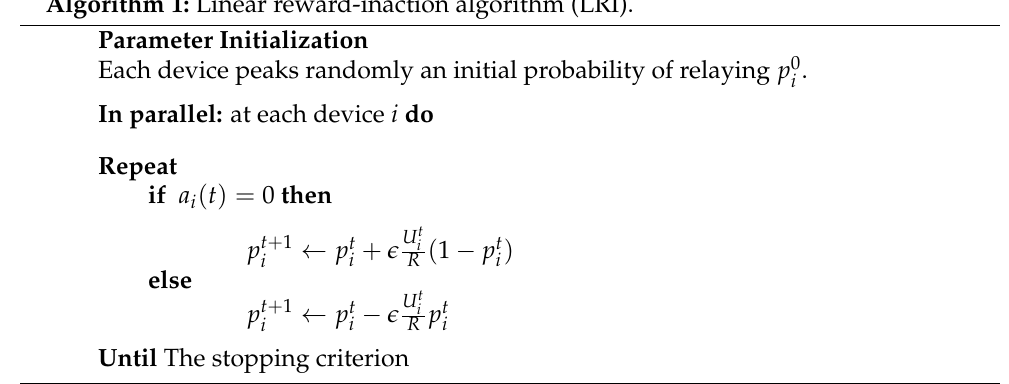
Algorithm 1: Linear reward-inaction algorithm